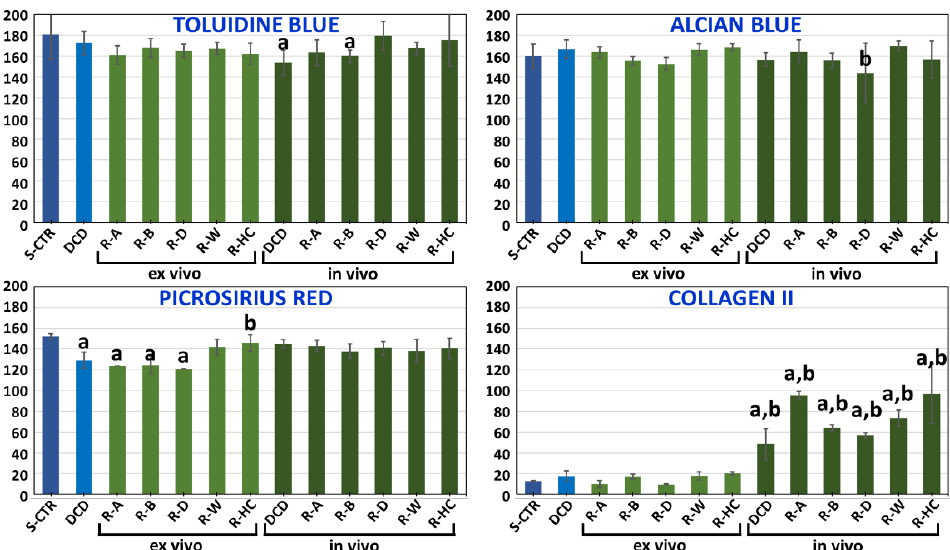
Figure 4. Quantitative analysis of proteoglycans as determined by toluidine blue and alcian blue, and of collagen fibers as determined by picrosirius red and type II-collagen, in S-CTR, DCD and RCD maintained ex vivo and grafted in vivo. Values correspond to reaction intensity for each histochemical or immunohistochemical method. R-A: RCD recellularized with MSC obtained from adipose tissue (ADSC); R-B: RCD recellularized with bone marrow MSC (BMSC); R-D: RCD recellularized with dental pulp MSC (DPSC); R-W: RCD recellularized with umbilical cord Wharton jelly MSC (WJSC); R-HC: RCD recellularized with human chondrocytes. a: Significantly different from S-CTR; b: Significantly different from DCD.